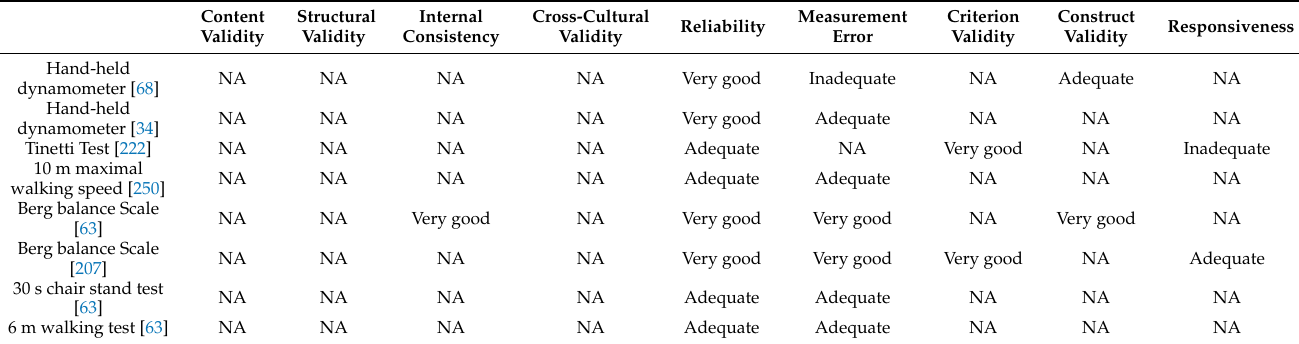
Table 4. Methodological quality of the studies that assessed the tests’ psychometric